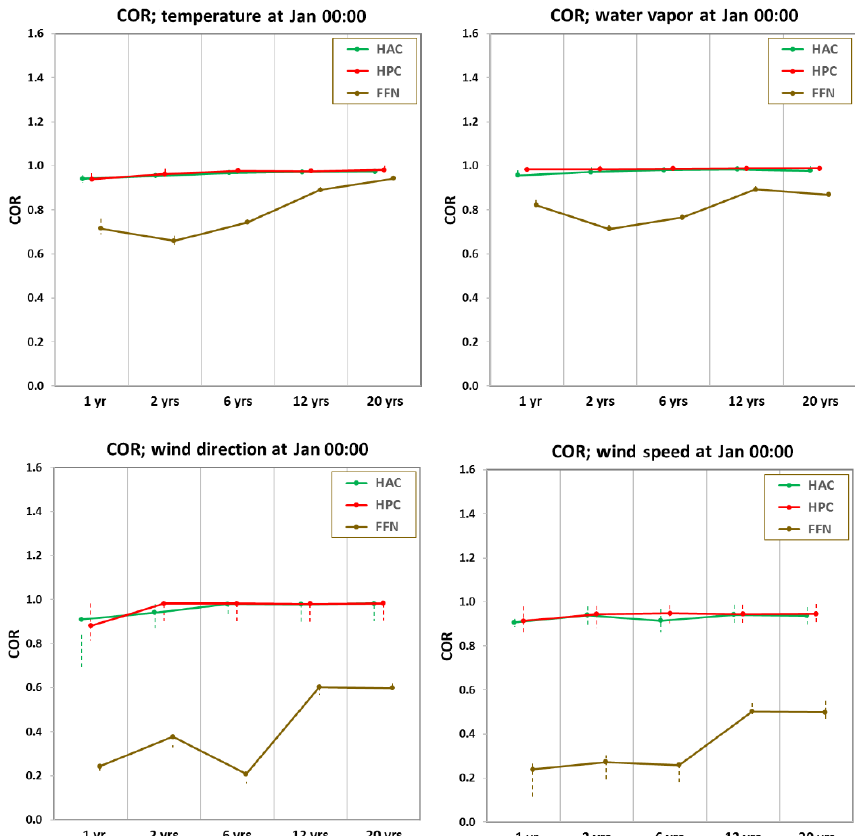
Figure 7. Same as Fig. 6 but for Pearson